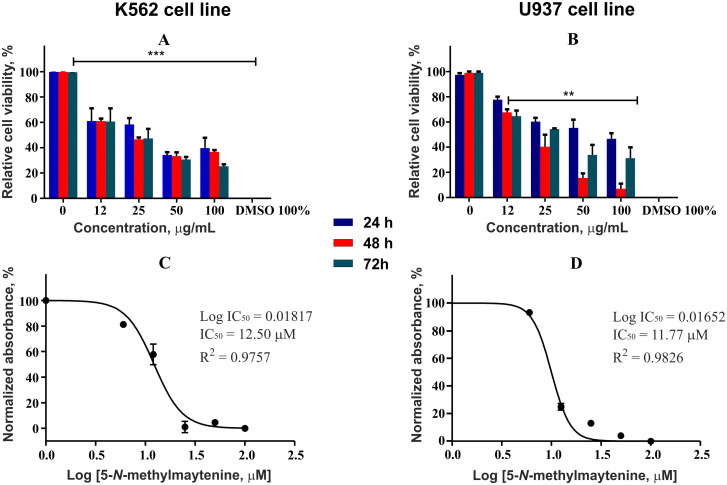
Cytotoxic activity of 5-N-methylmaytenine respective IC50 values.